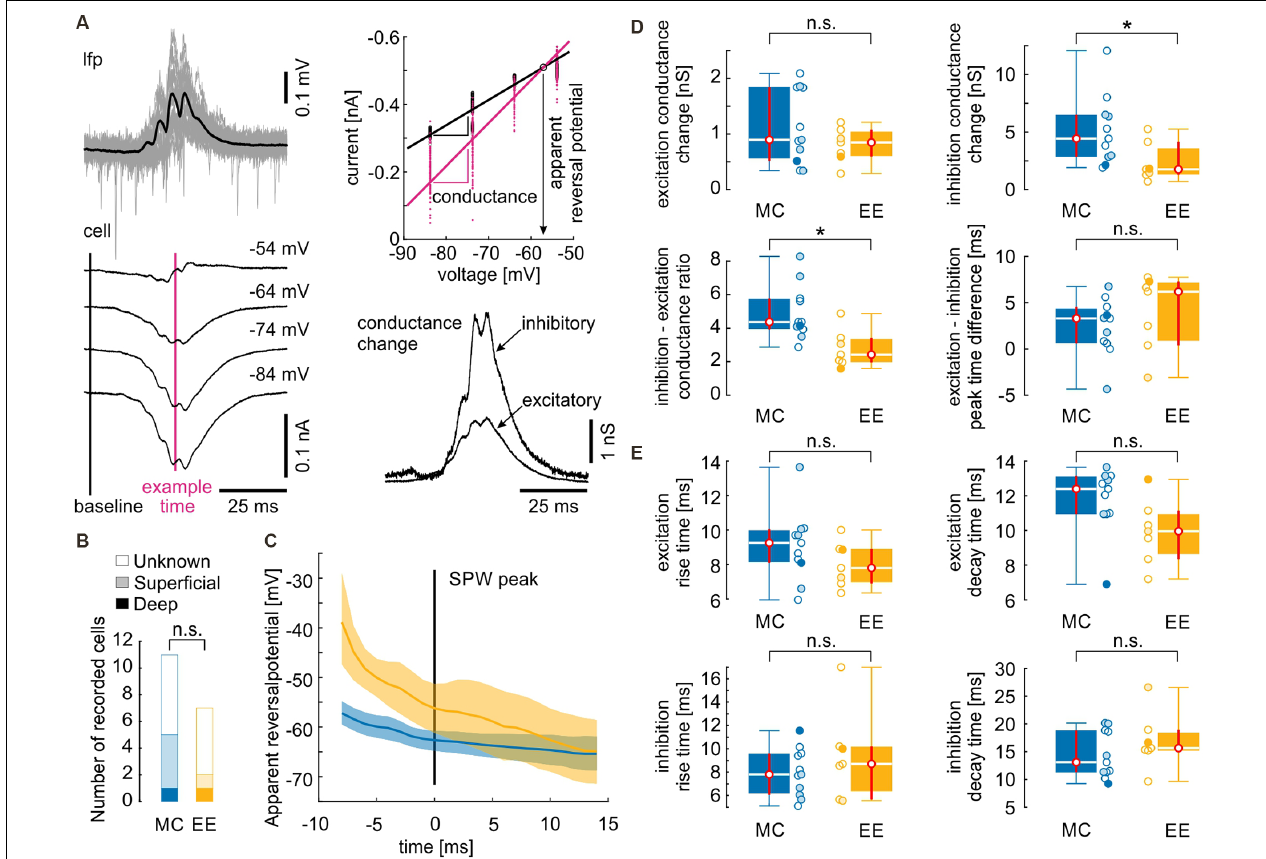
FIGURE 4 | Inhibitory inputs during sharp waves are reduced after environmental enrichment. (A) Illustration of conductance analysis (similar to Borg-Graham et al., 1998; Haider et al., 2006). SPW-R were aligned by their peak (upper left panel, black line is the mean SPW-R). Currents from different holding potentials (lower left panel; mean currents from one recording) yielded instantaneous membrane conductance by fitting their I–E relation (upper right panel): black line is the linear regression fitted to the individual values 30 ms before the SPW peak. The slope of the linear regression yields the input conductance of the cell. Every subsequent time point can be similarly fitted. As an example, the time point near the SPW peak is depicted in magenta. The intersection with the baseline regression yields the apparent reversal potential of the conductance change. This allows a separation of the conductance change into an inhibitory and an excitatory component which is depicted in the lower right panel (see also “Materials and Methods” section). (B) From the 18 recorded cells, only seven locations could be recovered. However, there is no evidence that the MC group mainly consisted of superficial cells while the EE group mainly consisted of deep cells or vice versa . (C) Time course of the apparent reversal potential. Lines depict the median values, the shaded areas depict the 95% confidence intervals assessed by bootstrapping. Apparent reversal potential is shifted towards more positive values in EE cells at the ascending phase of the SPW. (D) Excitatory conductance changes and timing between excitatory and inhibitory inputs do not differ between control and environmental enrichment. However, inhibitory conductance changes and inhibitory–excitatory conductance change ratio is decreased after environmental enrichment. (E) Dynamics of conductance changes quantified as the time between the 20% and the 80% value did not change after environmental enrichment. Open circles depict cells with unknown locations, lightly filled circles depict cells from the superficial layer and filled circles depict cells from the deep layer. N = 11 cells from four mice for motor control and N = 7 cells from four mice for environmental enrichment. Asterisks denote p -values < 0.05 computed by a Mann–Whitney U test. Red lines depict the confidence intervals of the median assessed by bootstrapping. n.s., not